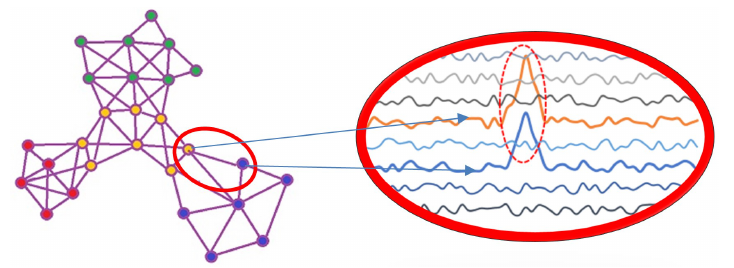
Figure 3. An example of two correlated